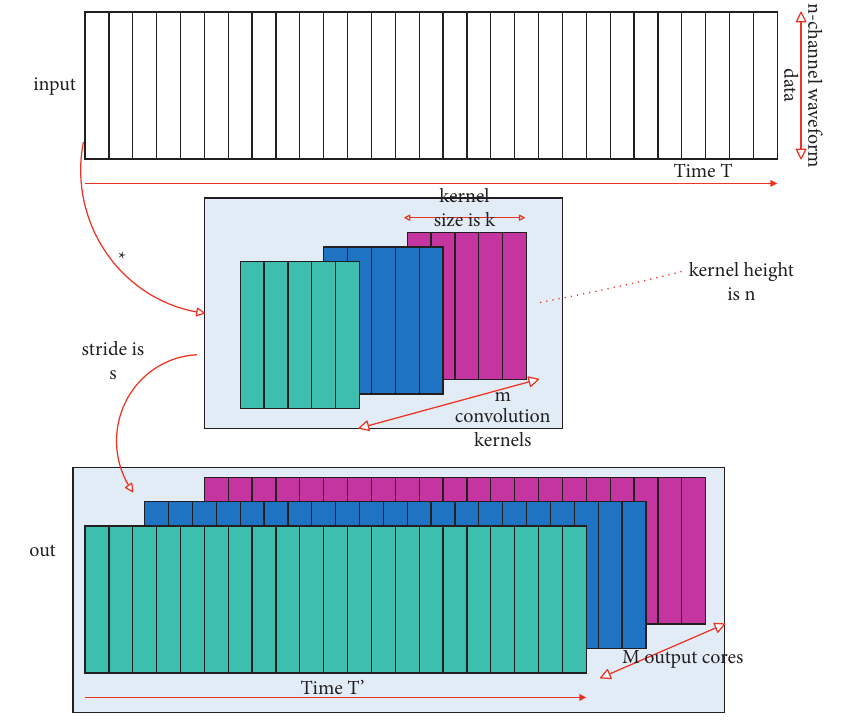
Figure 1: Conv1D convolution process of